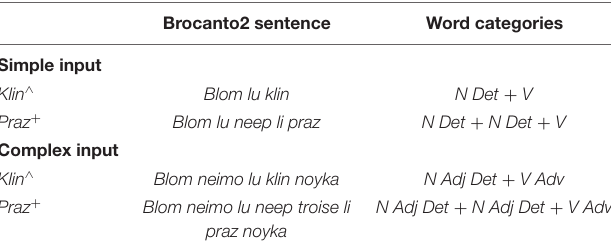
TABLE 2 | Examples of simple and complex input for klin and praz in